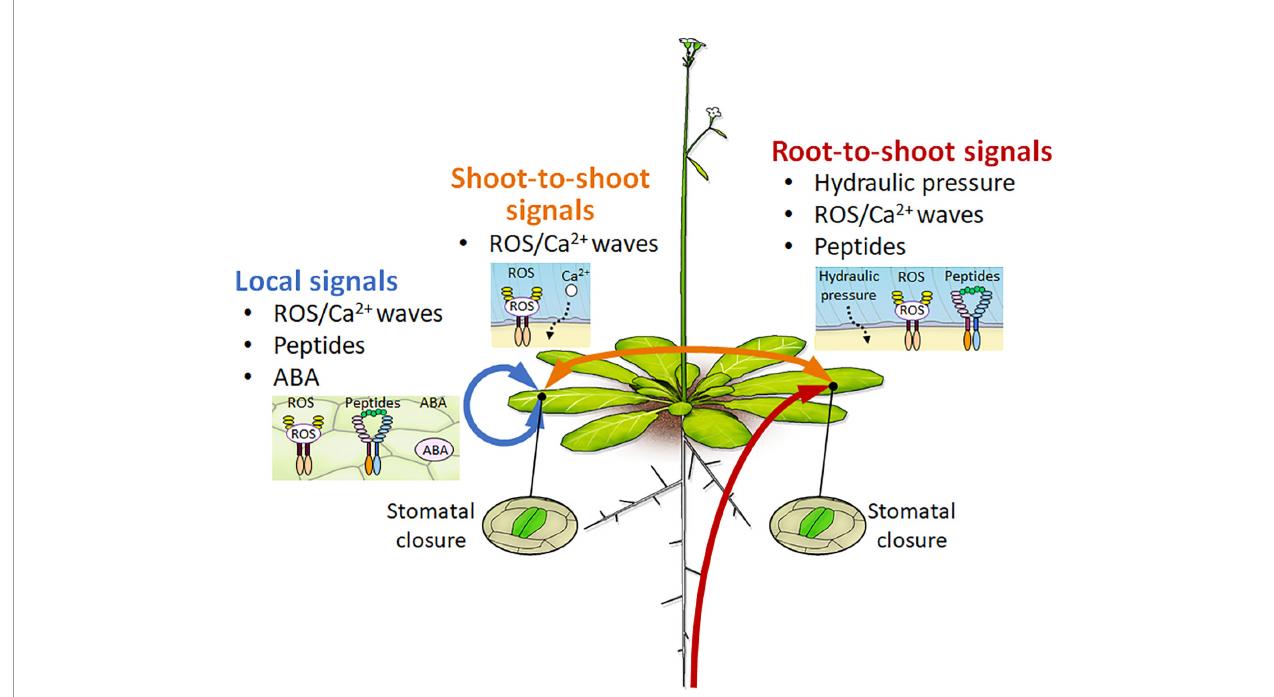
FIGURE 1 | Conceptual diagram of root-to-shoot, shoot-to-shoot, and local signals in response to drought stress conditions. Mobile signals such as hydraulic pressure, ROS/Ca 2+ waves, peptides, and phytohormones mediate tissue-to-tissue and long-distance communication for the acquisition of drought stress resistance at the whole-plant level. The red line indicates the root-to-shoot signals such as hydraulic pressure, ROS/Ca 2+ waves, and peptides signals under dehydration stress conditions. The orange line indicates the shoot-to-shoot signals of ROS/Ca 2+ waves to mediate stomatal closure under stress conditions. The blue line indicates the local signals of ROS/Ca 2+ waves, peptide, or ABA signals that mediate stomatal control under stress